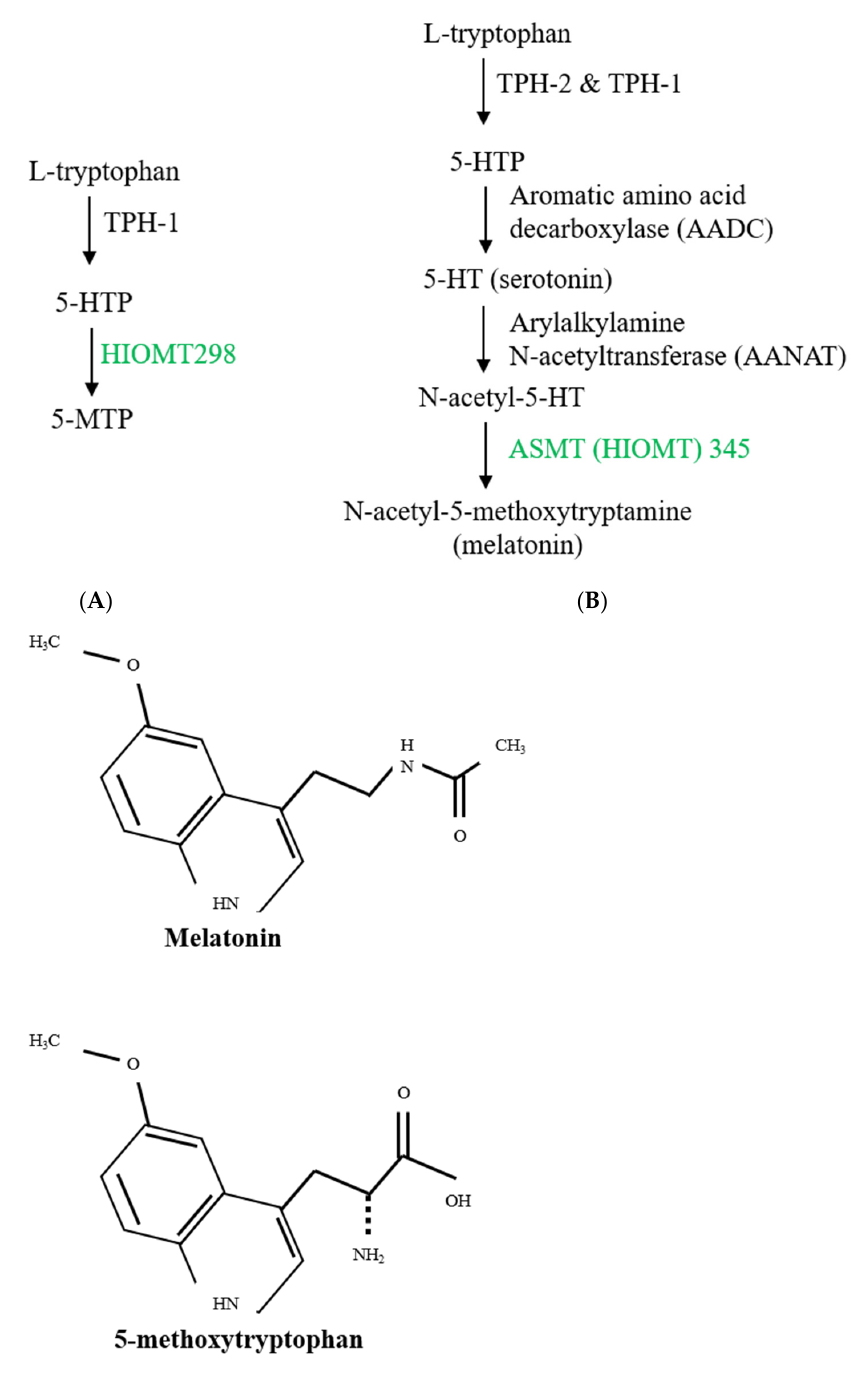
Figure 2. Biosynthesis of 5-methoxytryptophan (5-MTP) and melatonin. ( A ) 5-MTP is produced in human fibroblasts, bone marrow mesenchymal stromal cells (BM-MSCs), vascular endothelial cells (ECs) and SMCs, bronchial and renal epithelial cells. Its synthesis is catalyzed by TPH-1 (tryptophan hydroxylase-1) followed by hydroxyindole O-methyltransferase (HIOMT, also known as N-acetylserotonin O-methyltransferase, ASMT). HIOMT298 denotes HIOMT isoform coding for 298 aa HIOMT. ( B ) For comparison, melatonin biosynthesis in pineal cells is shown, highlighting HIOMT345 (ASMT 345) as the functional isoform. ( C ) Structural comparison between 5-MTP and